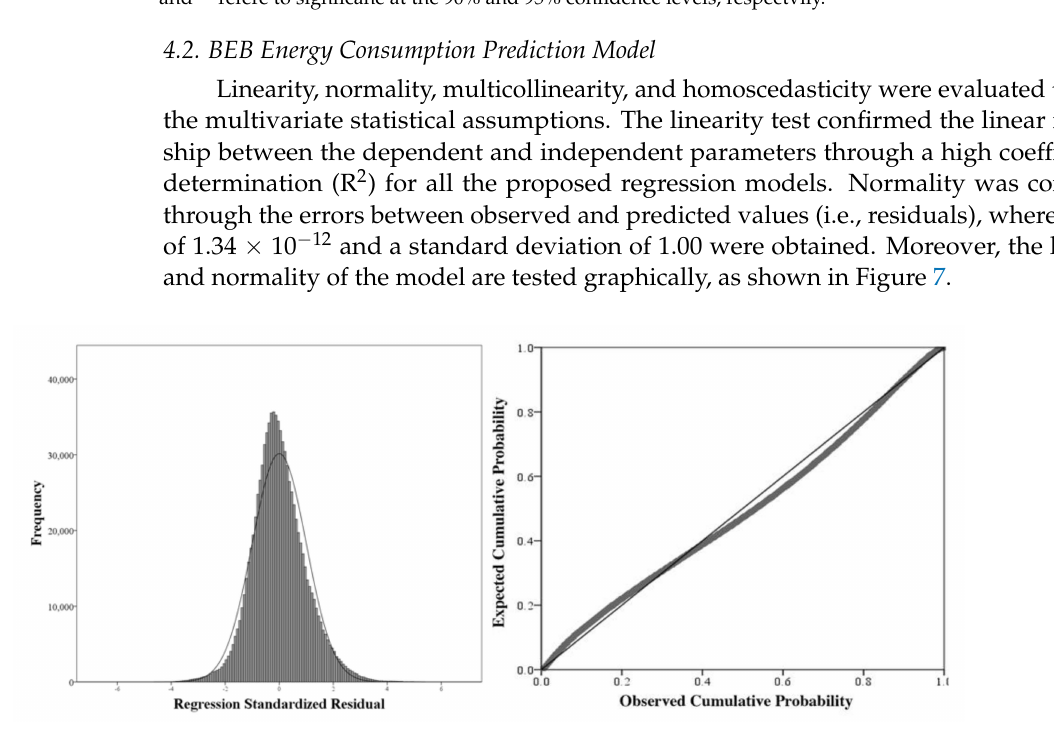
Figure 7. The distribution of the regression standardized